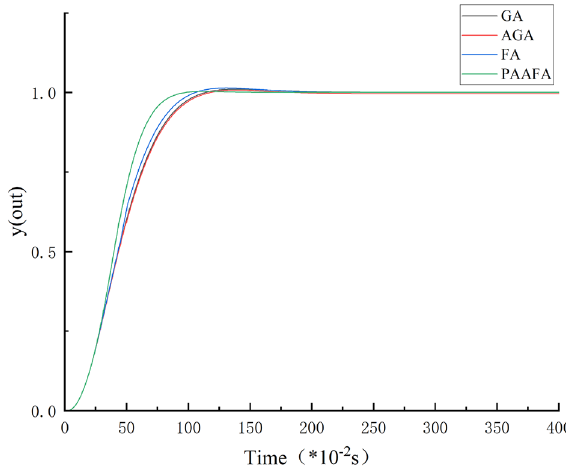
Figure 6. Unit step response curves of the 3